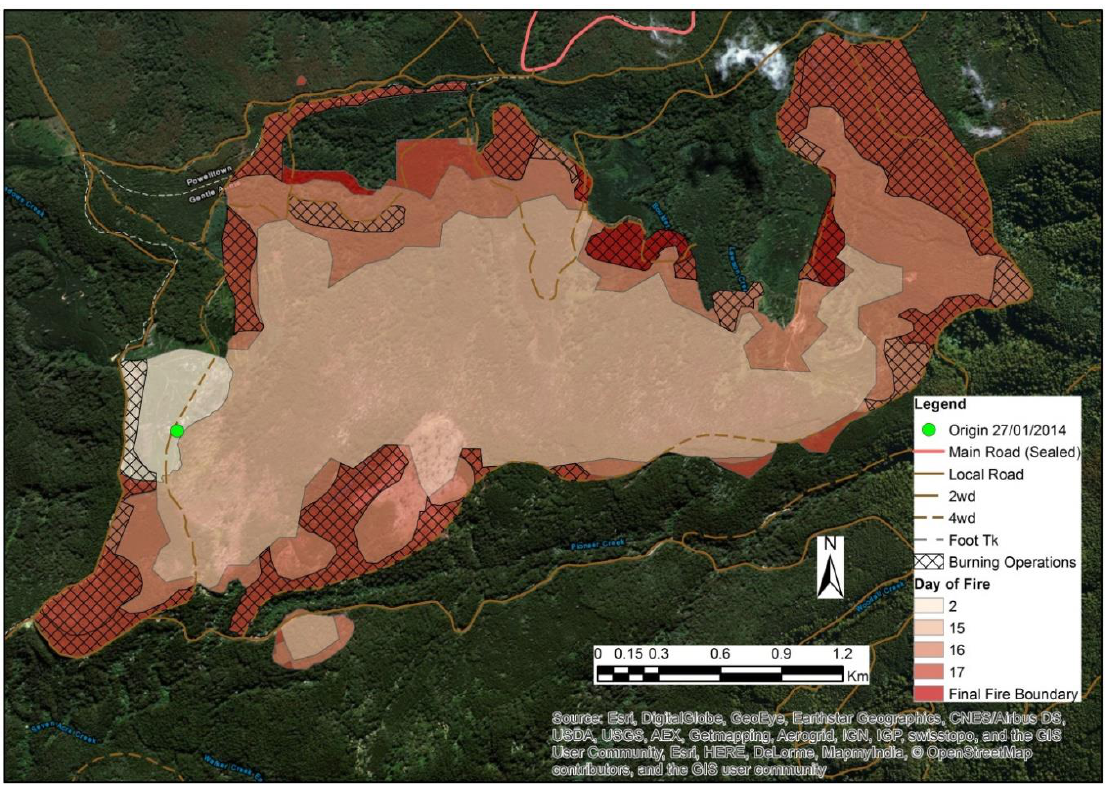
Figure A3. Powelltown fire progression map.